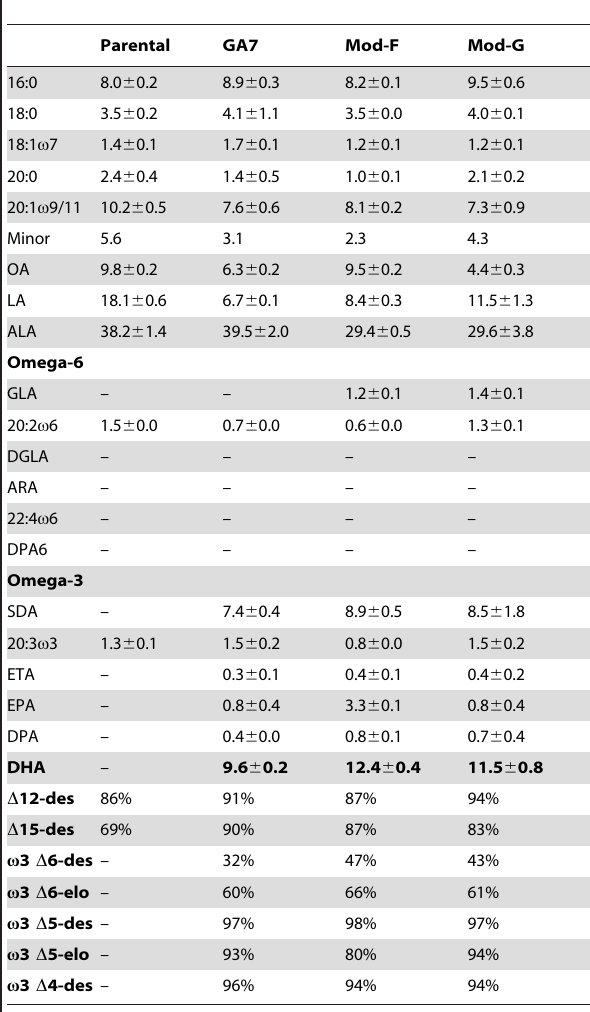
independent transgenic parental, GA7, mod-F and mod-G lines (T 2 seeds with the highest DHA